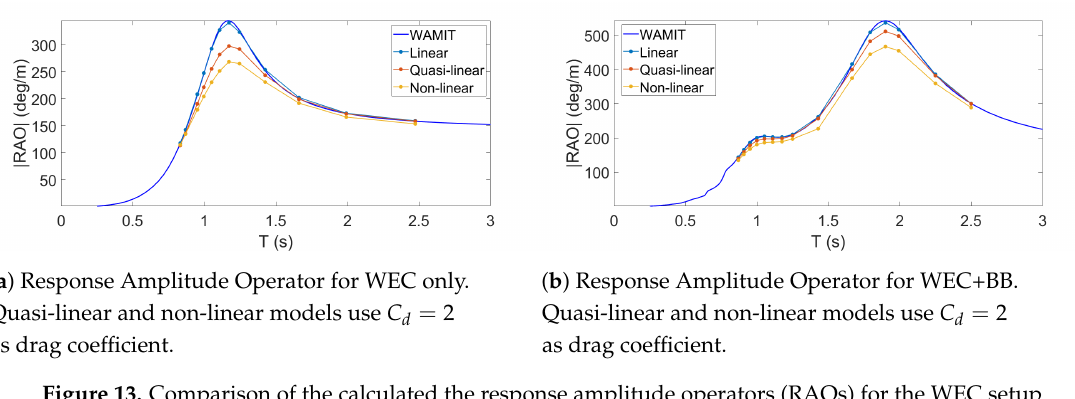
Figure 13. Comparison of the calculated the response amplitude operators (RAOs) for the WEC setup ( a ) and WEC+BB setup ( b ) for varying wave period ( T ) using different numerical models. The solid blue line (“WAMIT”) and the dotted blue line (“Linear”) are the RAOs calculated with potential theory. “Quasi-linear” refers to the model where all forces are linear except a simplified quadratic drag moment and “Non-linear" to the model where all forces are non-linear except radiation damping moment”. The biggest difference between numerical models corresponds to the natural period of the